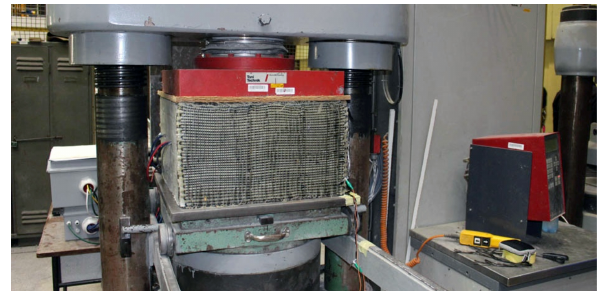
Figure 13: Textile sensor applied in the concrete beam of hydroelec- tric power